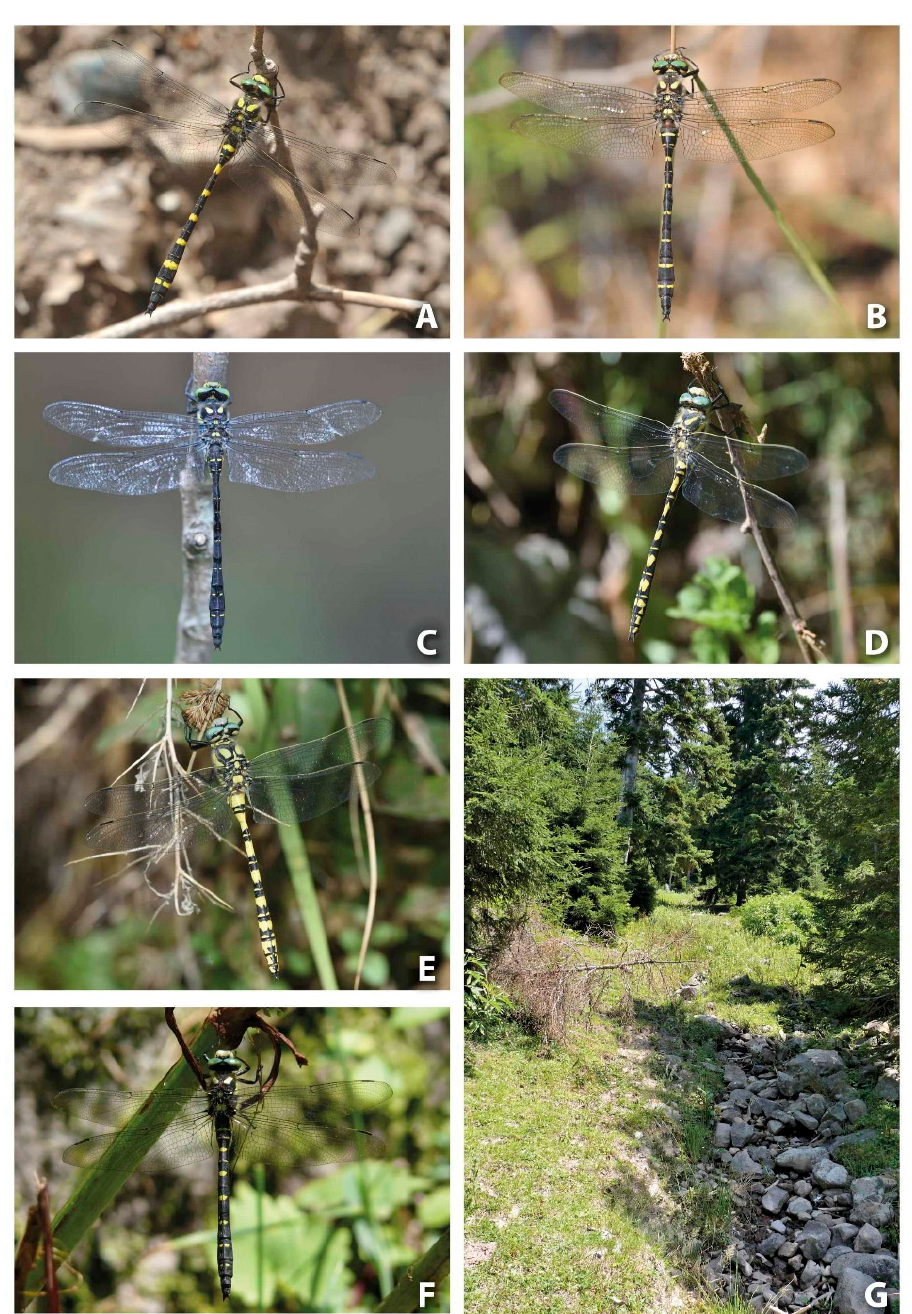
Figure 20. Some Cordulegaster in their natural environment and some of their habitats: ( A ): yellow form of C. picta (near Köycegiz, Turkey). ( B ): dark form of C. picta (near Mengen, Turkey). ( C ): C. vanbrinkae (Hyrcanian forest near Veysar, Iran). ( D ): C. coronata (near Arzaneh, Iran): ( E ): C. charpentieri (near Dorud, Iran): ( F ): C. mzymtae (Georgia, Adjara, 5 km E Goderdzi Pass). ( G ): C. mzymtae Habitat (Georgia, Adjara, 5 km E Goderdzi Pass). ( A – E ): photos Dietmar Ikemeyer, ( F , G ): photos Elias Schneider. C. mzymtae the darkest member of the bidentata -group occurs eastwards from